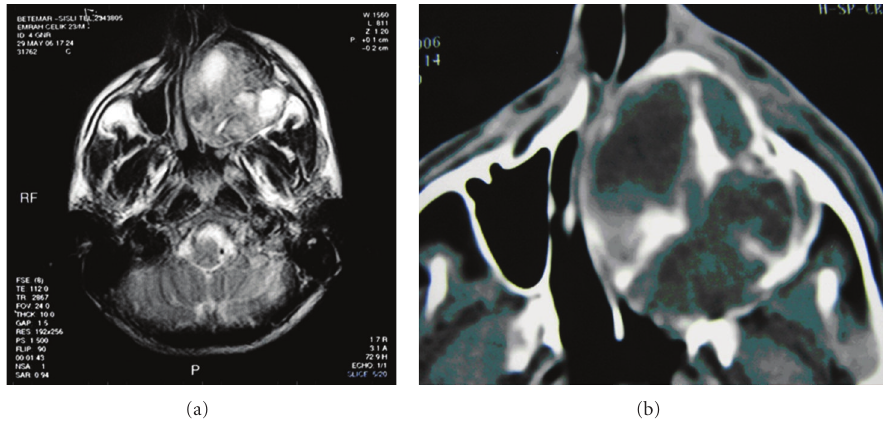
Figure 1: Cranial MR: multicentric osseous lesions in left maxillofacial bones.